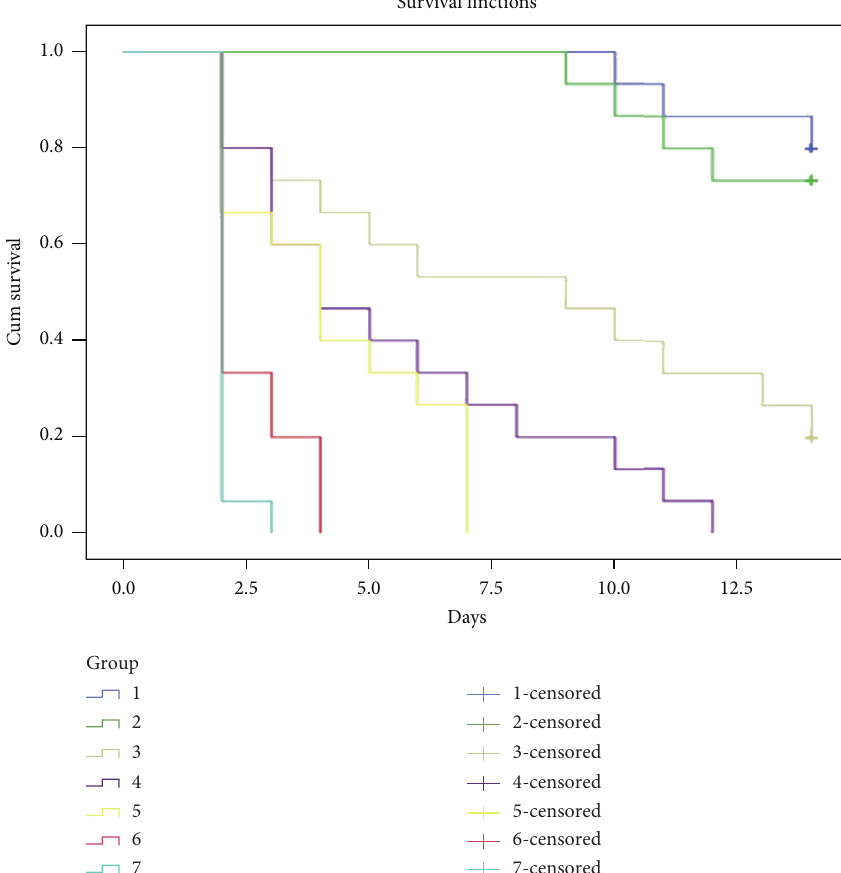
Figure 4: Chronic toxicity test of crude extract on the survival rate of adult Javanese medaka treated with different concentrations of the crude extract (100–400mg/L). The percentage of survival rate is shown versus concentration of crude extract. ∗ P < 0 . 01 represents significant different values of the control group and group exposed to crude extract. The values represent mean ± SD from three ( n � 3) independent